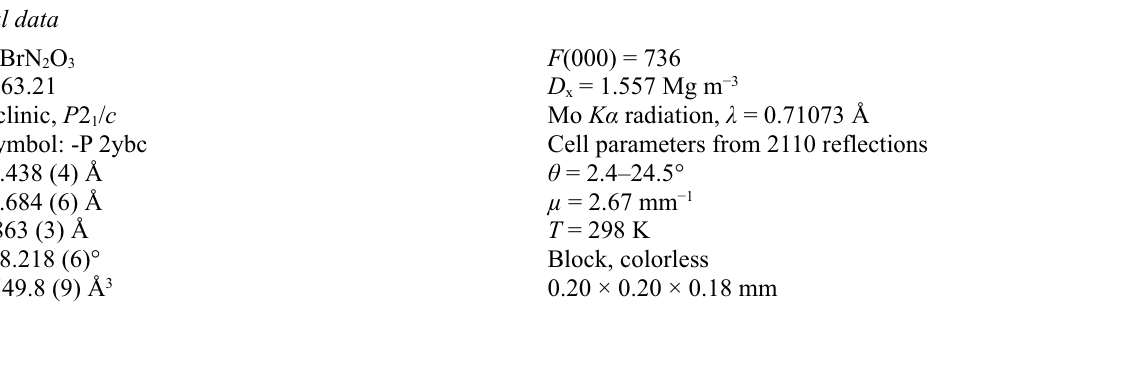
The packing diagram of (I), viewed along the b axis. Hydrogen bonds are shown as dashed lines. ( E )- N ′